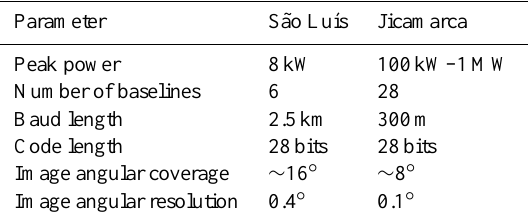
Table 1. Radar parameters for equatorial spread F imaging ob- servations. Jicamarca parameters are also shown for comparison purposes (Hysell et al.,